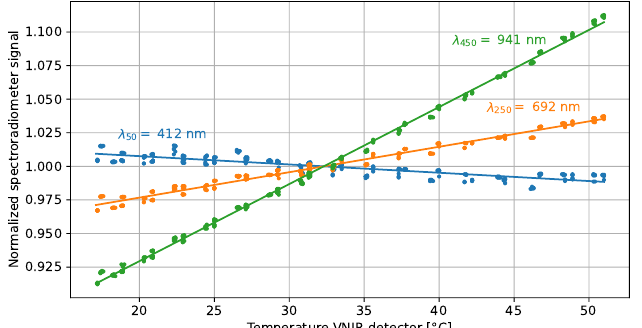
Figure 4. Temperature sensitivity measurements and linear fits of three channels in the VNIR detector array of the spectroradiometer. The spectroradiometer signals have been normalized to the response at a reference detector temperature of 32.3°C. The labels indicate the center wavelength λ c of the plotted